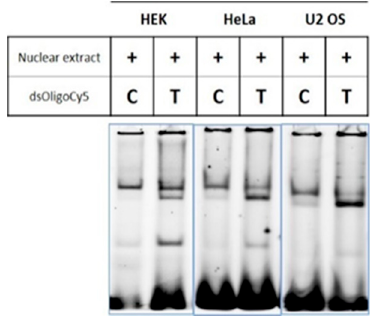
Figure 5. The Electrophoretic Mobility Shift Assay (EMSA) profiles of the C and T alleles of c.-68C>T variant are different. EMSA was performed using labelled oligonucleotides (dsOligoCy5) containing the C or T allele corresponding to CLSPN c.-68C>T. The oligonucleotides were incubated with nuclear extracts from HEK293, HeLa and U2 OS cells. Each band corresponds to a distinct protein-DNA complex formed during incubation of nuclear extracts with the labelled oligonucleotides. Unbound/free oligonucleotides are detected at the bottom of the gel. The assays were repeated at least three times for each cell line and a representative experiment is shown. Detailed information can be found at Figure S3.